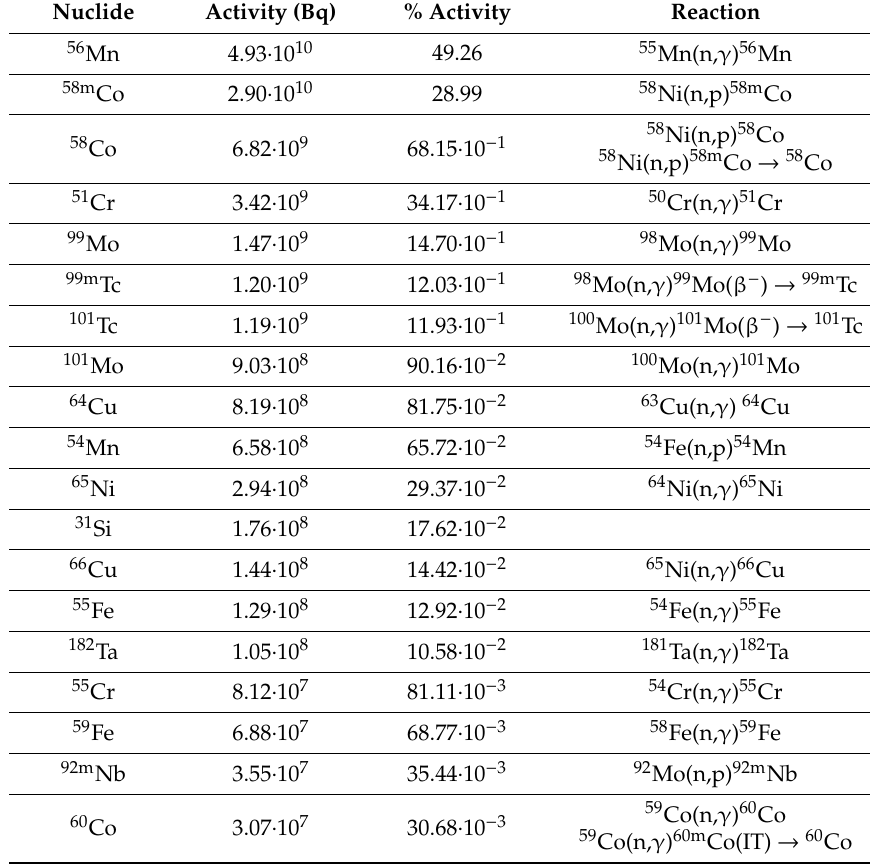
Table 5. Activation after 10 min cooling time for the Megavolt ITER Injector and Concept Advancement (MITICA) dump, from D-D